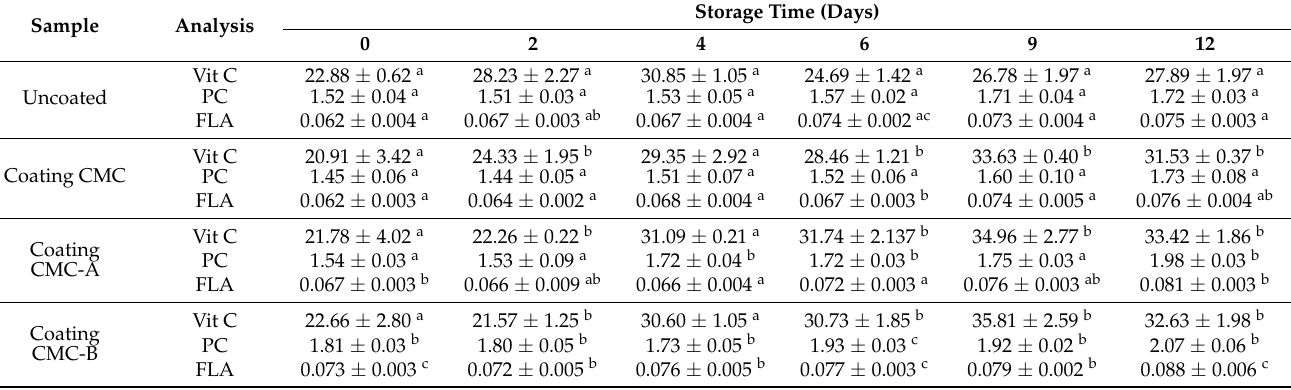
Table 3. Vitamin C (Vit C), total phenolic compounds (PC), and flavonoids (FLA) values of the coated and uncoated fresh goldenberries stored at 20 ◦ C and 65% RH for 12 days.